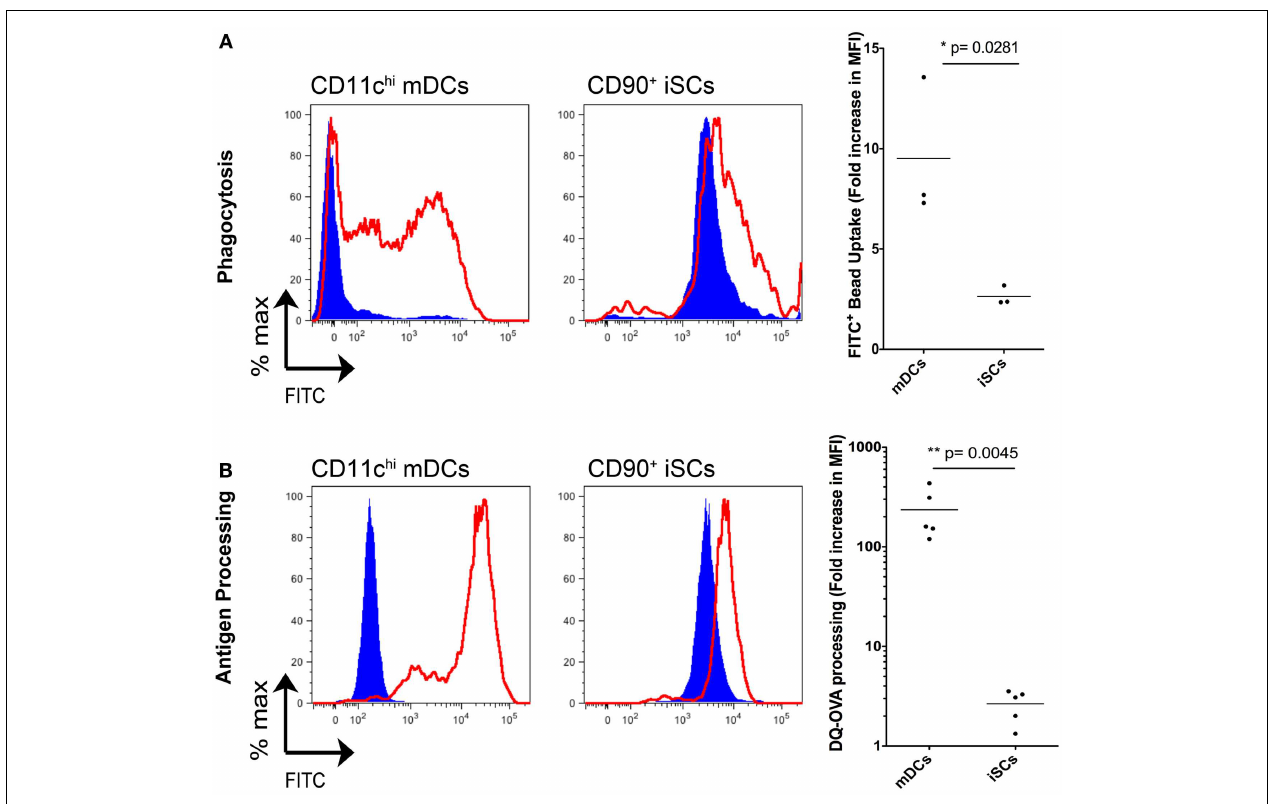
processing by CD11c + mDCs or CD90 + iSCs, determined by flow cytometry after pulsing with DQ-OVA at either 4°C (blue filled histograms) or 37°C (red open histograms), expressed as the fold increase in FITC MFI expression by cells at 37°C vs. 4°C. Data in (A,B) show mean fold increases in FITC MFI by mDCs and iSCs from n = 3–5 patients. P values as